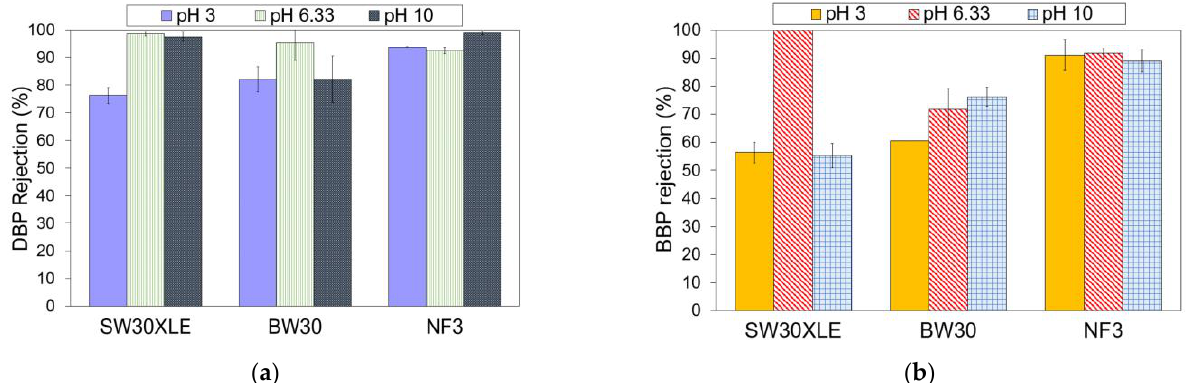
Figure 6. Effect of pH on the membrane performance for the removal of ( a ) DBP and ( b ) BBP.